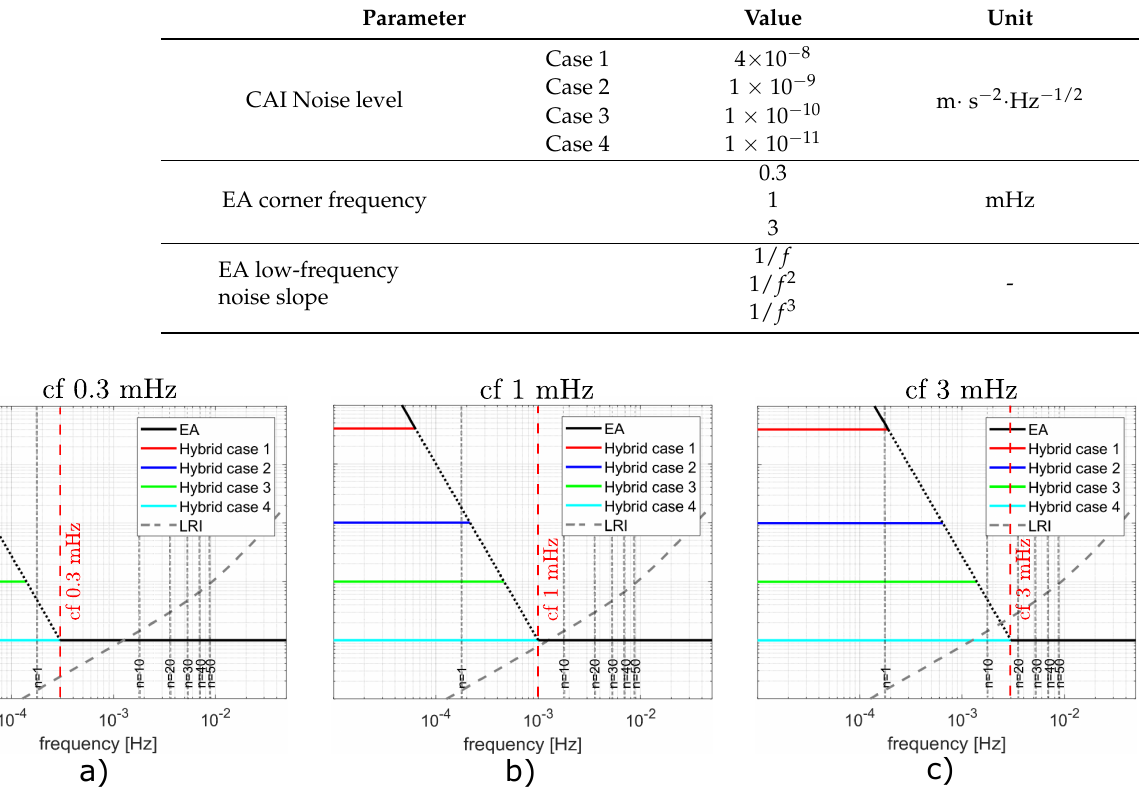
Figure 6. ASD of the EA/CAI hybridization scenario and a regular EA assuming a 1/ f 3 noise slope and corner frequencies (cf) of 0.3 mHz ( a ), 1 mHz ( b ), and 3 mHz ( c ). The dotted line depicts the spectrum common to the respective hybridization scenario and the stand-alone EA. Vertical dashed grey lines represent the maximal contributing observation frequency to spherical harmonic coefficients of the given degree. The thick dashed grey line represents the laser ranging interferometer noise in terms of range